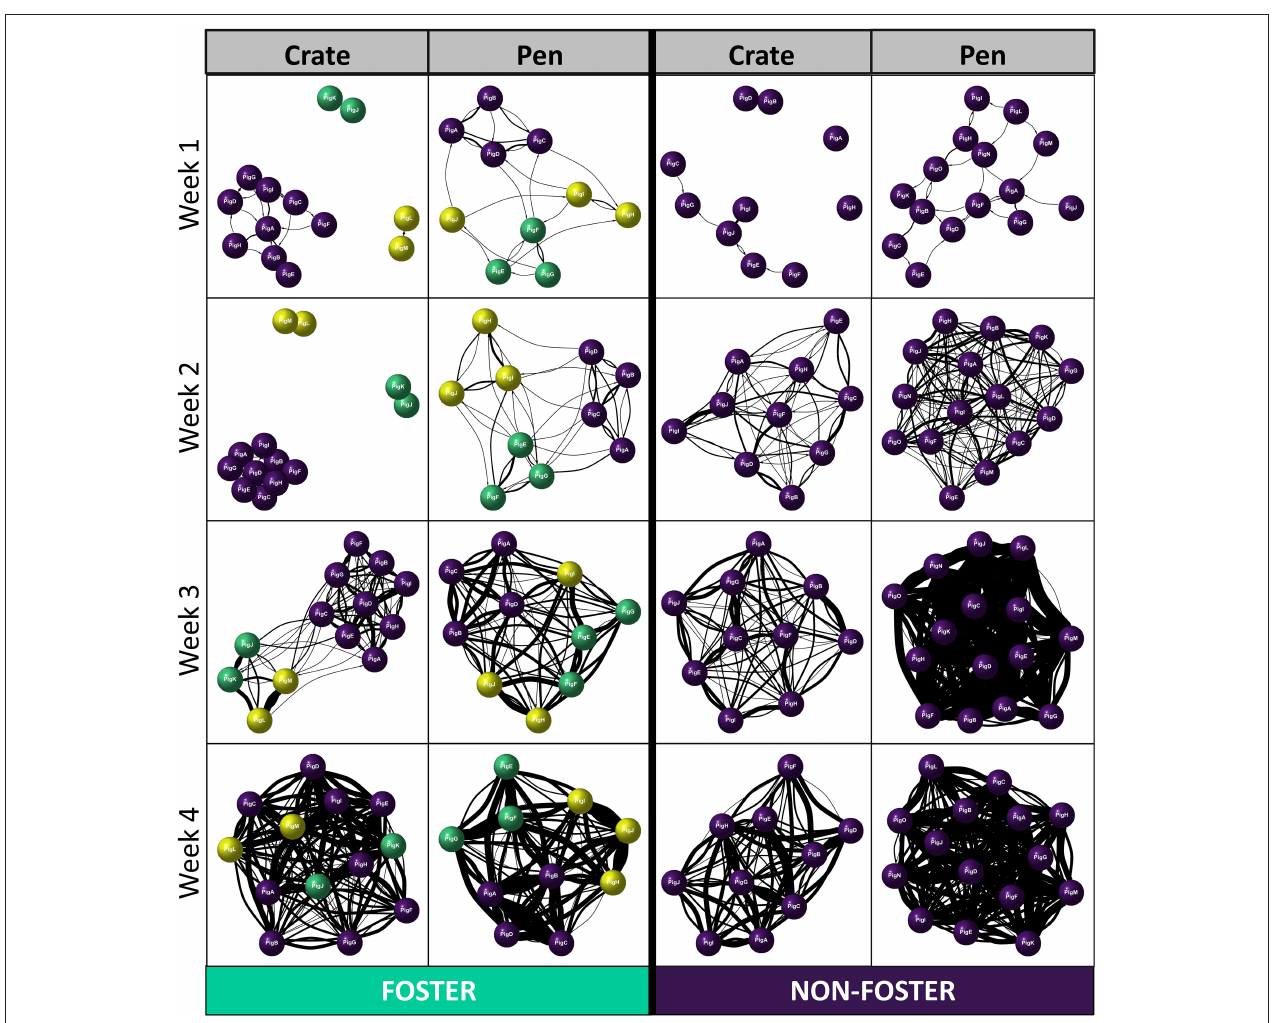
FIGURE 4 | Examples of directed Social Network Analyses (SNA) across the two neonatal environments (Crate and Pen), separated according to week post-farrowing and foster status (Foster or Non-foster). Purple nodes represent non-foster piglets, green and yellow represent foster piglets; same colour denotes siblings from the same original litter. Thickness of the edges (lines) represents a greater number of play invitations between